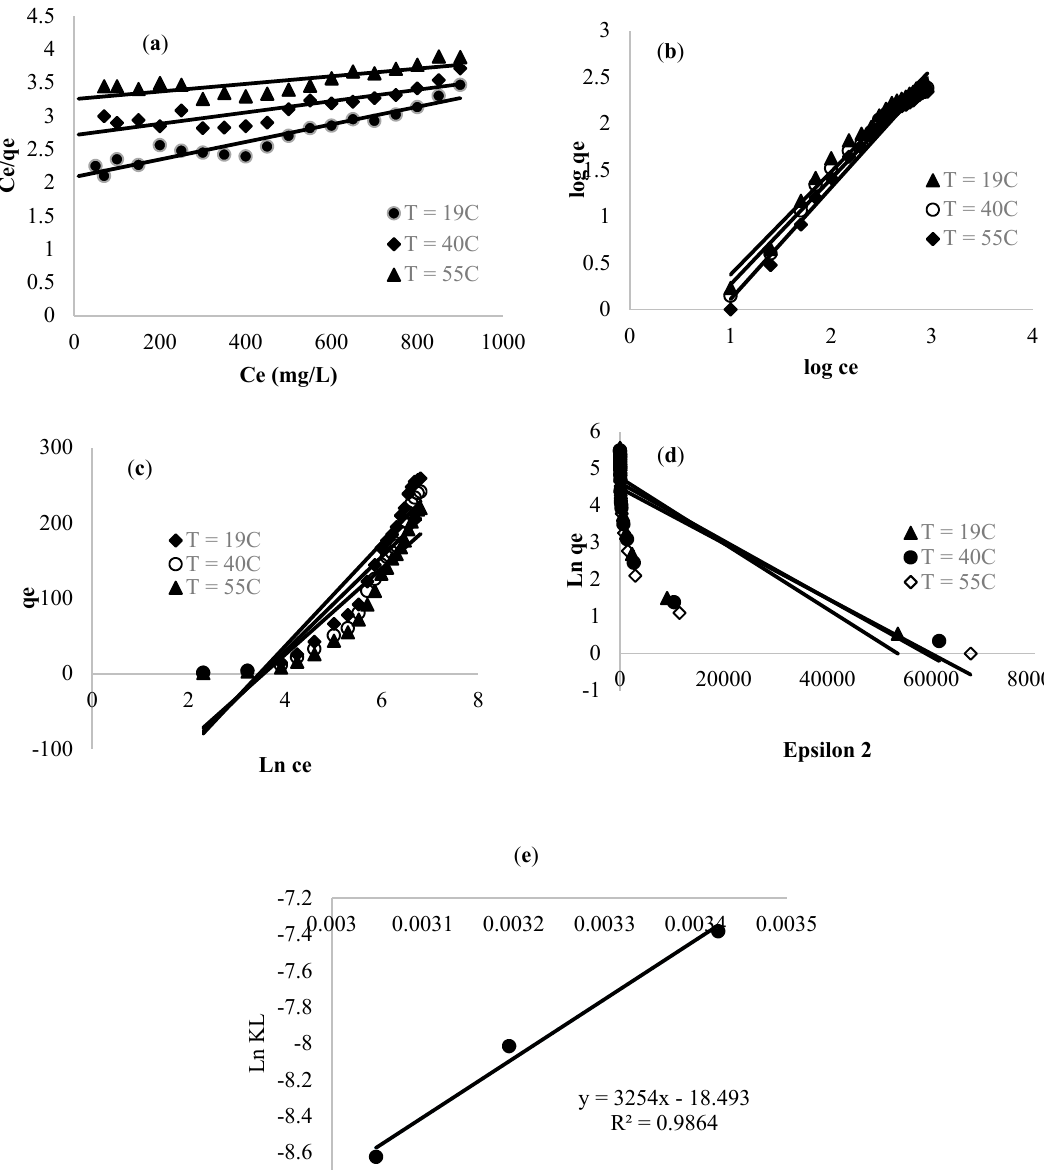
Figure 8. Linearization of the adsorption data of methylene blue using Nerium fruit through ( a ) Langmuir, ( b ) Freundlich, ( c ) Temkin, ( d ) Dubinin isotherms, and ( e ) plots of Ln Kl versus the inverse of temperature.